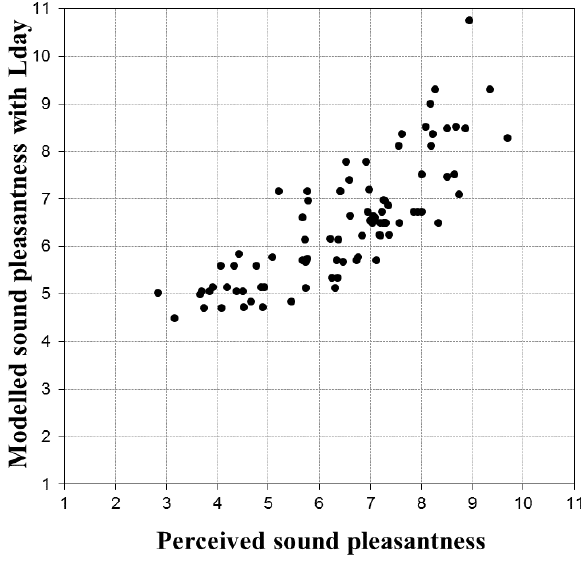
Figure 10: Relationship between perceived sound quality and this quality modelled by Eq. 16.